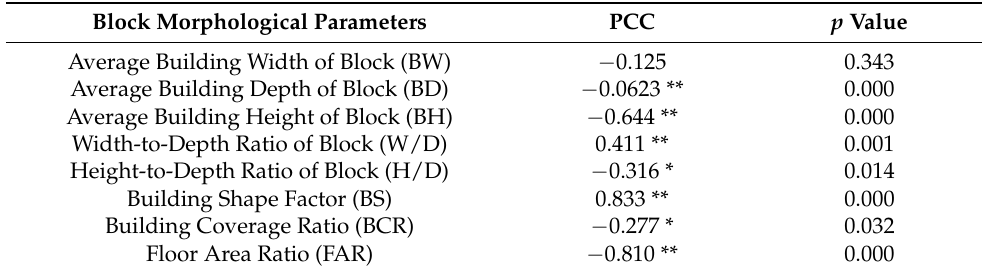
Table 4. Pearson correlation coefficient and p value in the linear regression relationship between block morphological parameters and building